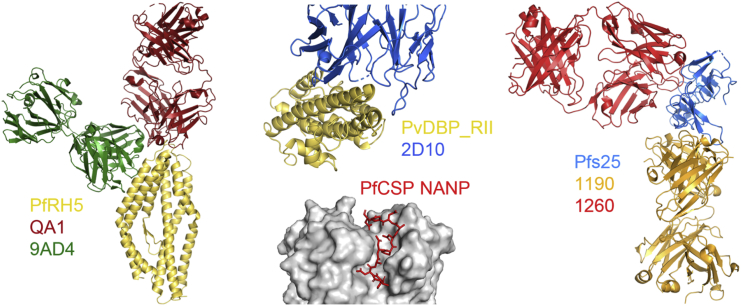
A Structure-Guided Approach to Malaria Vaccine DevelopmentStructures of essential Plasmodium surface proteins in complex with Fab fragments from mAbs provide a potential starting point for structure-guided vaccine development. Inhibitory mouse mAbs (9AD4 and QA1) binding on PfRH5 are shown (Wright et al., 2014). A mouse binding-inhibitory antibody (2D10), which can prevent PvDBP_RII from binding to human erythrocytes, has been shown to bind to the tip of its third subdomain (Chen et al., 2016). Antibodies that bind the NANP repeats of PfCSP prevent hepatocyte invasion by sporozoites (Oyen et al., 2017). Structural studies have also revealed Pfs25 bound to six different mouse mAbs, identifying two transmission-blocking epitopes, illustrated by the complexes with 1190 (epitope I) and 1260 (epitope II) (Scally et al., 2017).